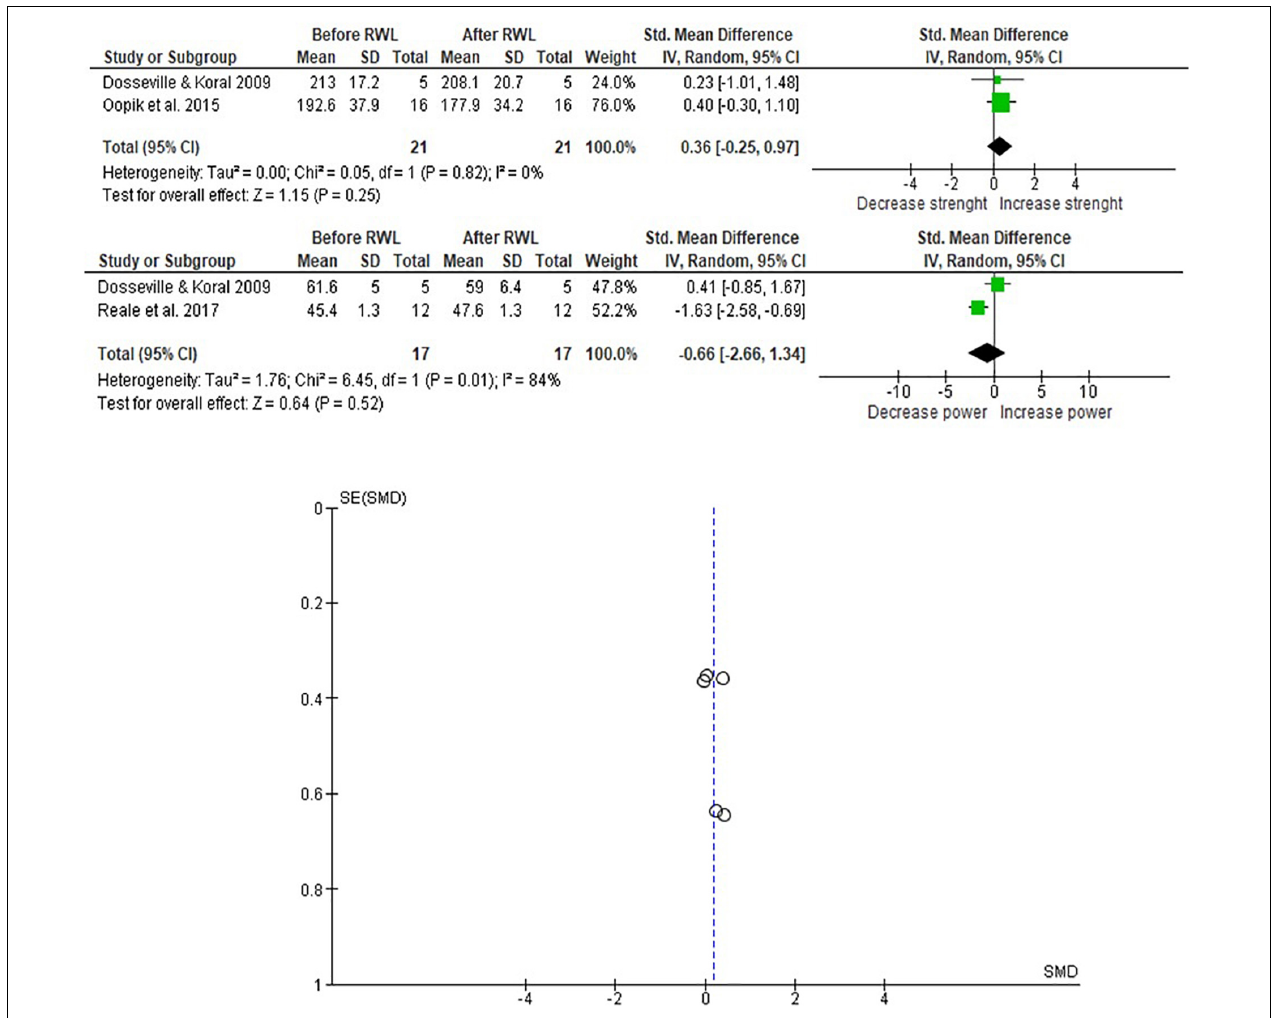
FIGURE 3 | Meta-analysis considering RWL studies with ∼ 5% of Olympic combat athletes’ body